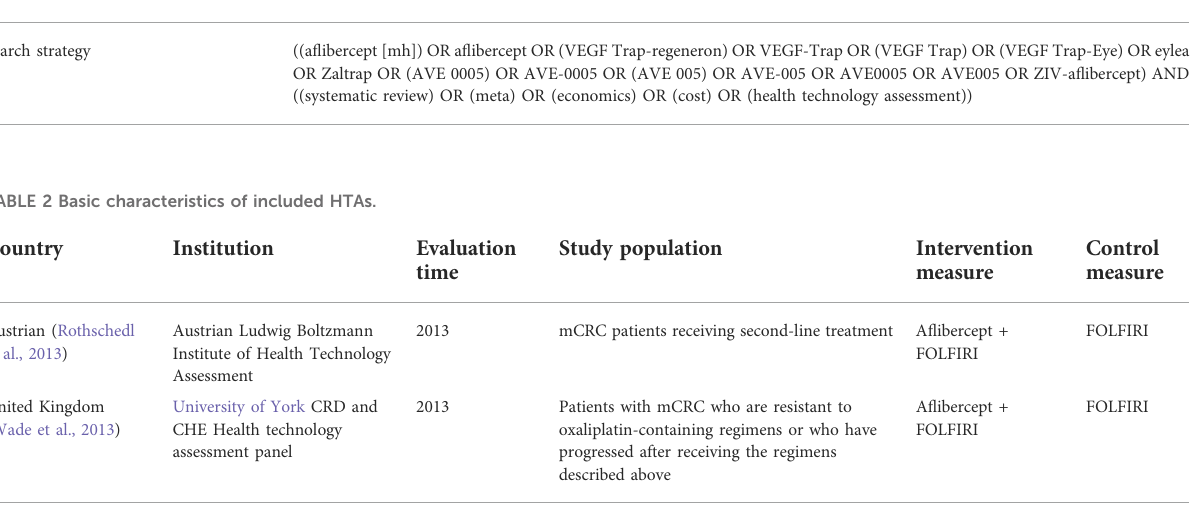
TABLE 1 Search strategy for PubMed.